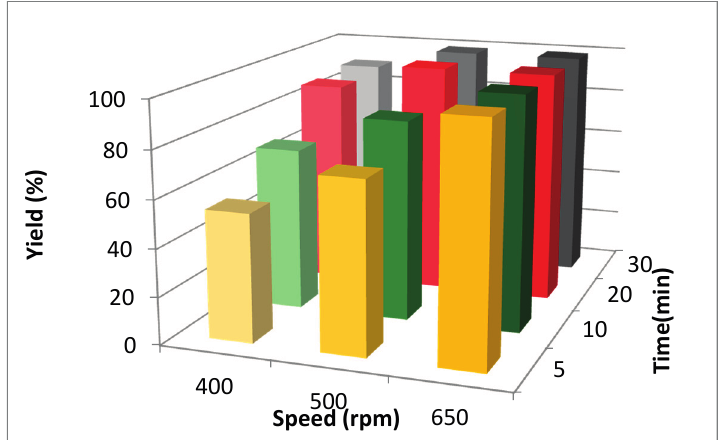
Figure 3. Influence of rotation frequency and milling time on product yield ( 3a ). Reaction